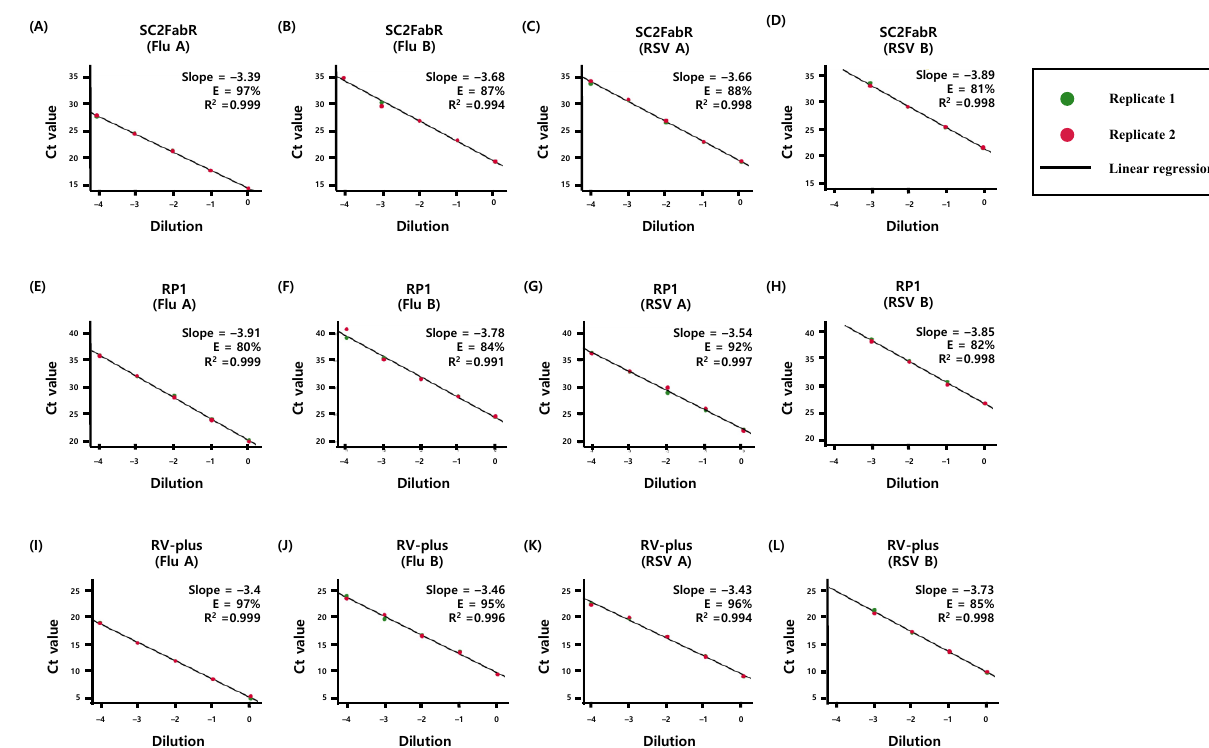
Figure 2. PCR efficiency for the detection of respiratory viruses. The PCR efficiency of the amplification of each target gene using three assays [SC2FabR ( A – D ), RP1 ( E – H ), and RV-plus ( I – L )] was assessed using duplicate 10-fold dilution series of Flu and RSV viral RNA. Linear regression analysis was performed using the SPSS software to obtain the slope and R 2 values. The percentage efficiency was calculated from the slope using the formula E = 100 × ( − 1 + 10 −1/slope ). Flu A, influenza virus type A; Flu B, influenza virus type B; RSV A, respiratory syncytial virus A; RSV B, respiratory syncytial virus B; RT-PCR, reverse-transcription PCR.